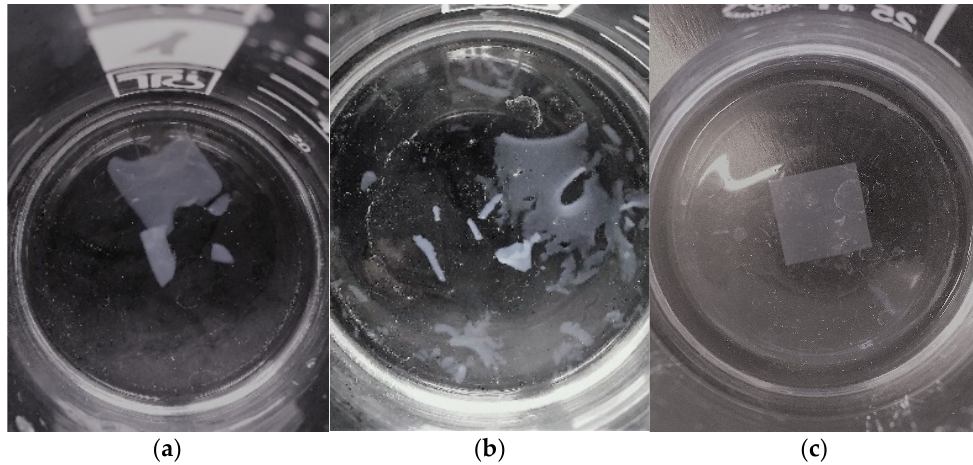
Figure 5. Interaction of CNC fi lms, plasticized with 15% glycerol, with liquid water. Photos were taken after 10 min treatment. ( a ) Neat fi lm; ( b ) CA-30% fi lm; ( c ) CA-30% fi lm heated at 160 °C for 10 min. The 15% glycerol and 30% citric acid make the CNC fi lm highly sensitive to liquid water. The disintegration of the loose structure containing a signi fi cant amount of plasti- cizer (15% + 30%) occurs within a few minutes. The nanocrystals are embedded in a high amount of plasticizers as a matrix. The rapid swelling releases the nanocrystals, and, in contrast to the disintegration mechanism of the previously discussed fi lms, the CA-30% fi lm disintegrates into fi brils within a short time (Figure 5b). It is well-known that esteri fi cation of hydroxyl groups of cellulose with citric acid takes place at high temperatures [11,23]. Therefore, in the CNC fi lms discussed previ- ously, no esteri fi cation in the CNC/glycerol/citric acid system occurred. For fi lms heated at 160 °C, the esteri fi cation and crosslinking are con fi rmed by the properties of the fi lms. Although the water vapor sorption of free citric acid and cellulose molecules is signi fi cant, the formation of the ester group reduces the number of free hydroxyl groups, resulting in a slightly lower water uptake (magenta curve in Figure 4) than that measured for the non- heat-treated CA-30% fi lms (black curve, Figure 4). Furthermore, the crosslinking process results in a fi xed fi lm structure, which can be characterized by limited accessibility and swelling. These all explain the resistance of fi lms to the disintegrating e ff ect of liquid wa- ter. The heat-treated fi lms are stable and did not degrade over the 48 h study period (Fig- ure 5c). CNC fi lms crosslinked with an amino-aldehyde compound behaved similarly in wa- ter [4]. It was observed that the fi lms with lower crosslinking agent content (0, 2.5, and 5%) disintegrated at higher crosslinker concentrations (10% or more); however, they re- tained their shape. In a further experiment, the swelling of these fi lms was characterized. After immer- sion in distilled water at room temperature for 24 h, the excess water was removed from the surface of fi lms and the mass was measured. The swelling rate of fi lms depends sig- ni fi cantly on the temperature of heating treatment and citric acid concentration (Table 2). No crosslinking occurs during heat treatment at 100 °C; independently from the citric acid concentration, the fi lms delaminate in a short time by a progressive and in fi nite swelling. Thus, for the non-crosslinked fi lms, the swelling rate is not possible to measure.